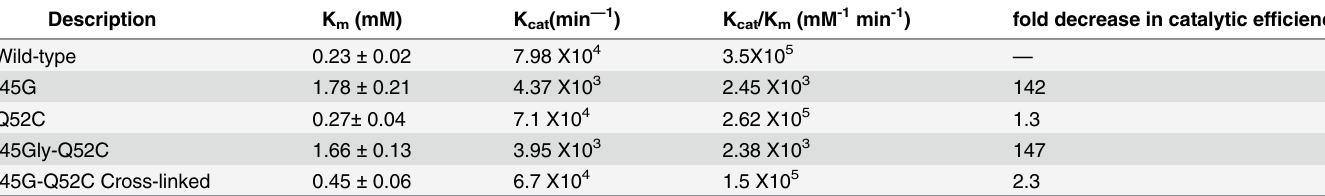
Table 5. Catalytic parameters of I45G-Q52C double mutant before and after